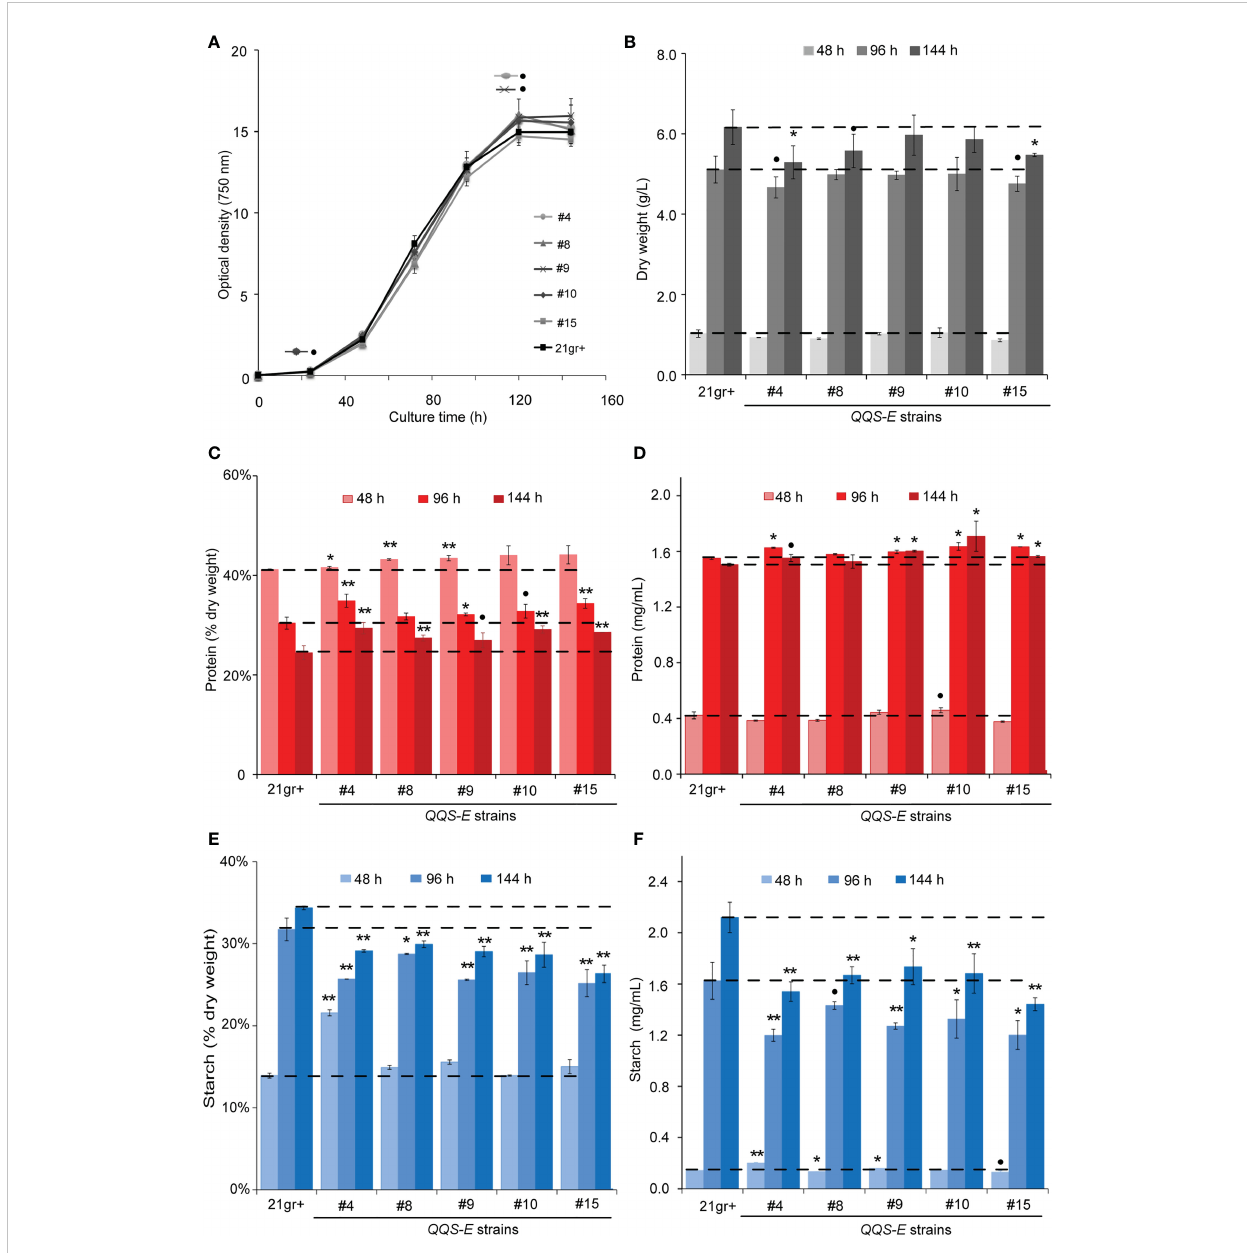
FIGURE 3 The effect of transgenic expression of QQS on the growth, starch and protein content in Chlamydomonas reinhardtii . Cultures were grown photoautotrophically to the stationary phase. Growth of the strains was determined by monitoring the optical density at 750 nm (A) , and biomass yield (B) of WT (C) reinhardtii (21gr + ) and transgenic QQS-E strains at the indicated times after subculturing. (C – F) Protein and starch content of WT (21gr + ) and transgenic QQS-E strains at the indicated times after subculturing. All data are mean ± SE (standard error), n = 3. Statistical signi fi cance relative to the WT strain was calculated with Student ’ s t -test and is indicated: ** P < 0.01, * P < 0.05, (cid:129) P <